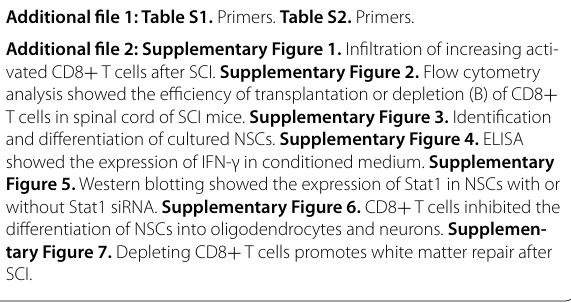
5, **** P < 0.0001, Student’s t =